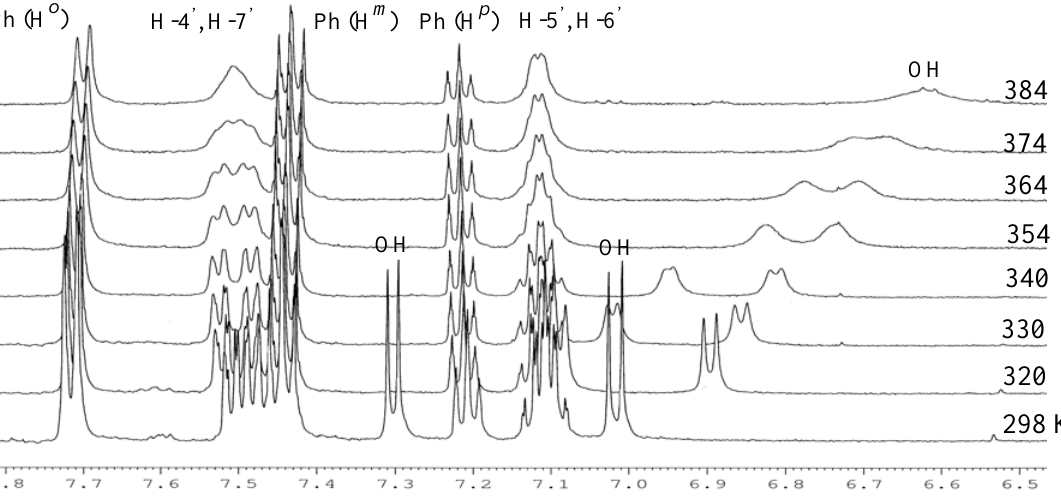
1 H-NMR spectra of the aromatic region of 5f P P